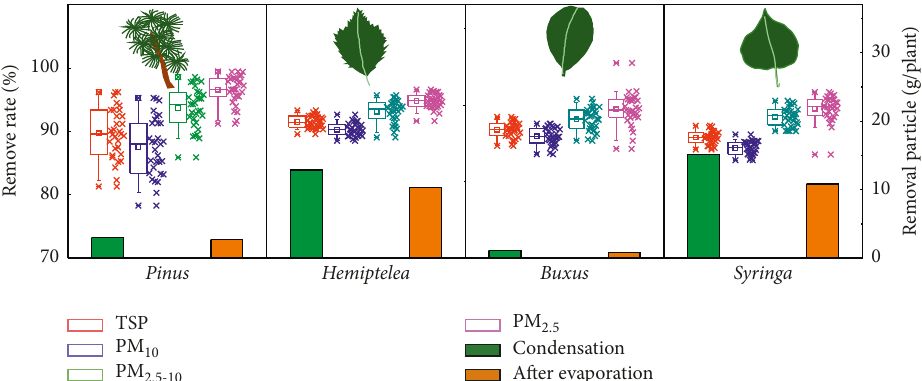
Figure 4: The amount of particles by different leaves and the removal rate of particles of different particle